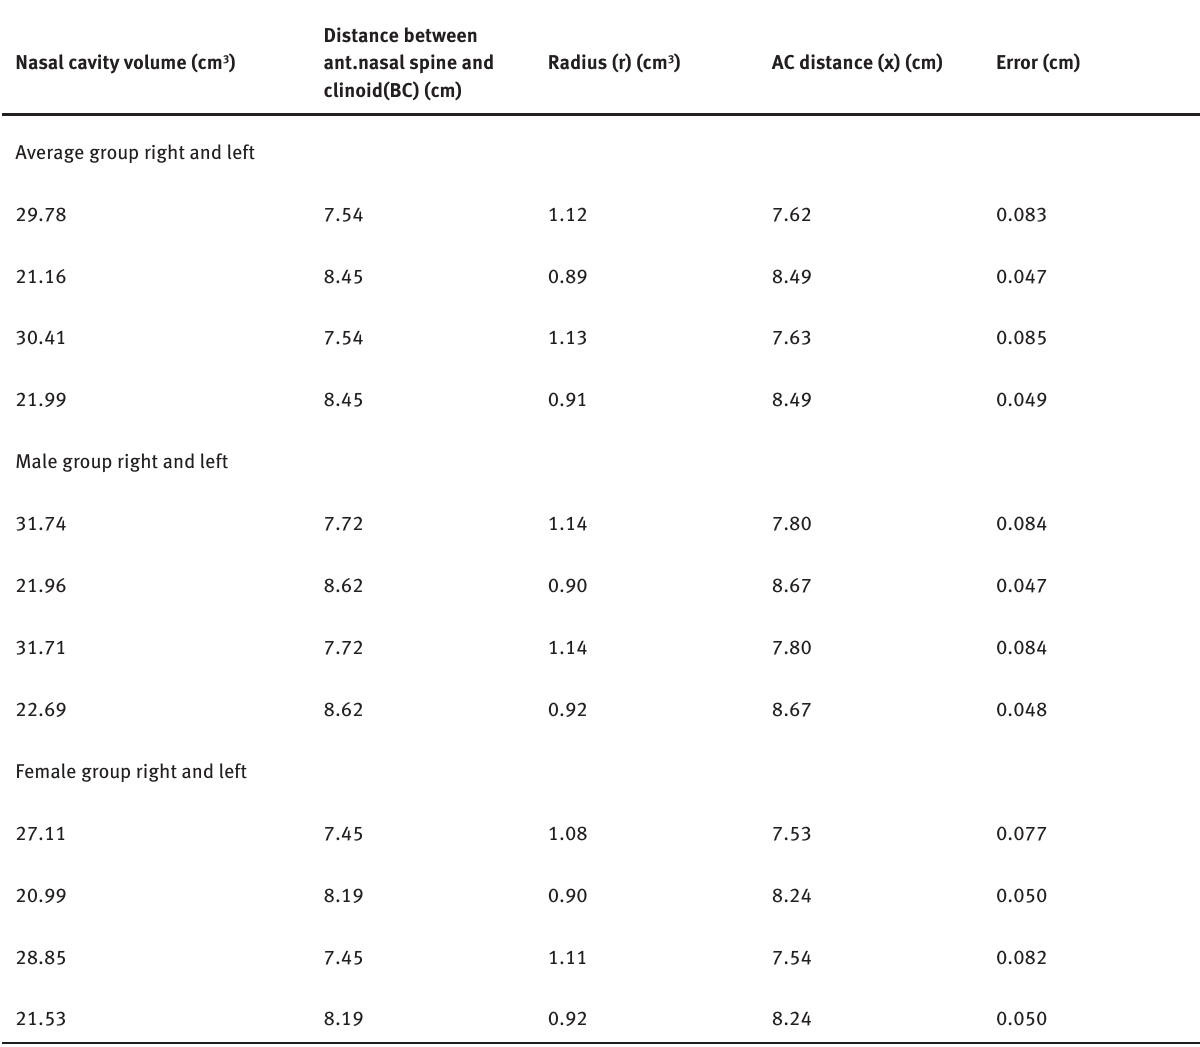
Table 4: Statistics pertaining to the estimated distances between BC, AC and radius.